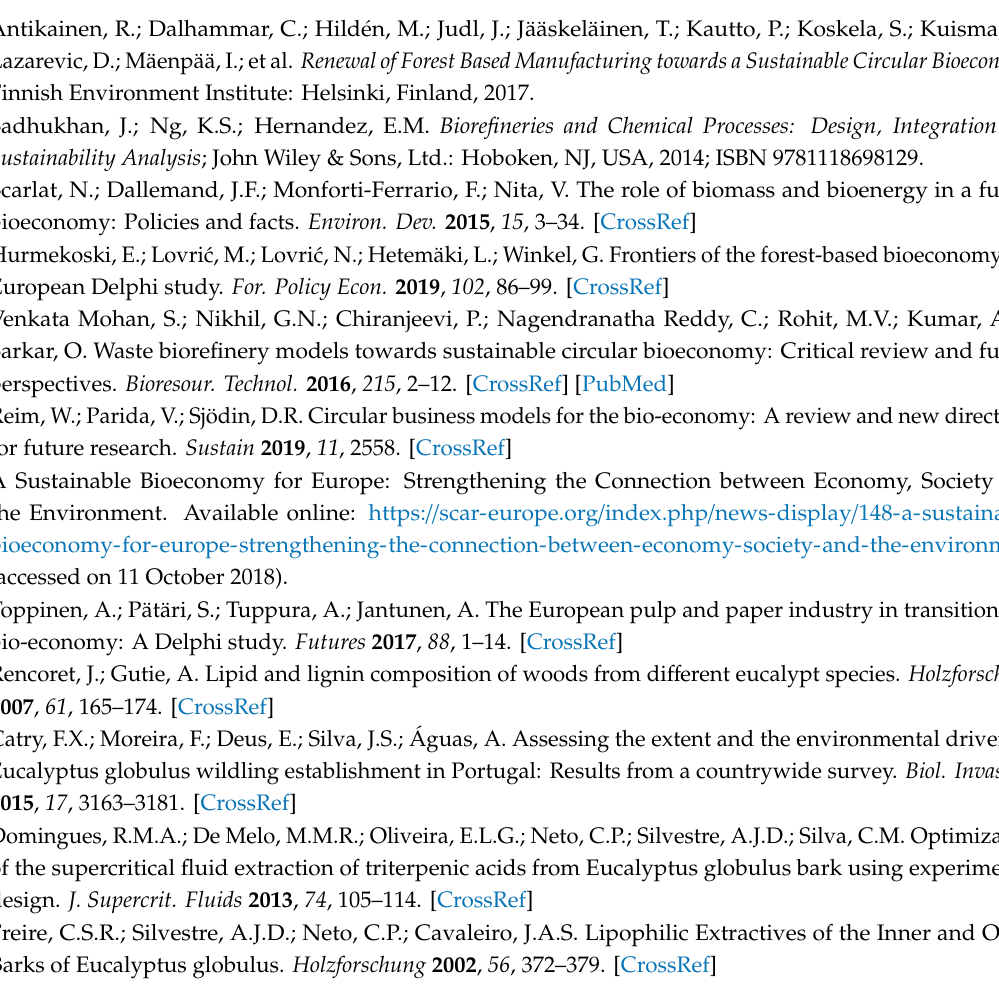
Supplementary Materials: Figure S1. Illustrative HPLC chromatogram corresponding to the extraction of TTAs using the NADES menthol:thymol 1:2 at 90 ◦ C (0.15 S / L